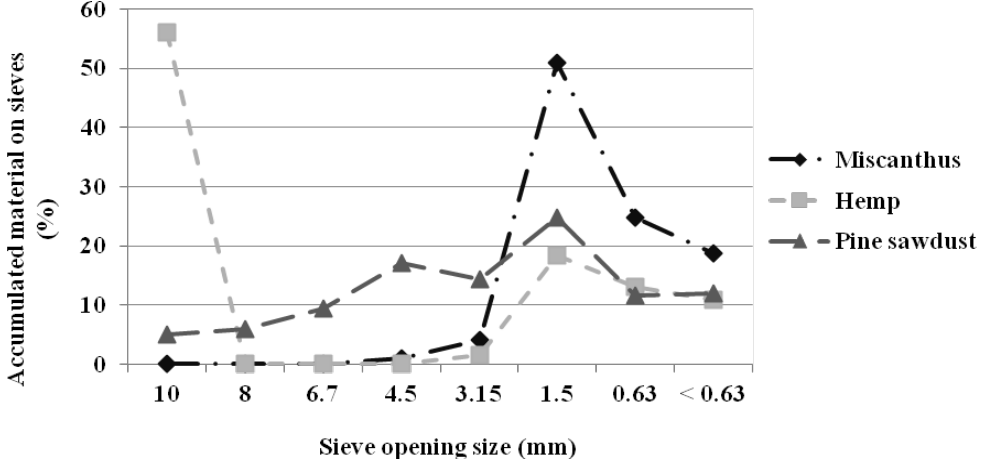
Figure 2. Comparison of particle size distribution (PSD) of studied materials.